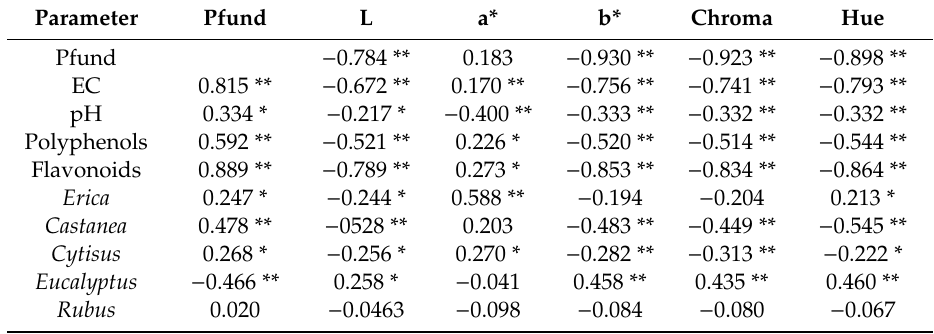
Table 3. Spearman rank correlation coe ffi cients among colorimetric parameters, physicochemical variables, and main pollen types.